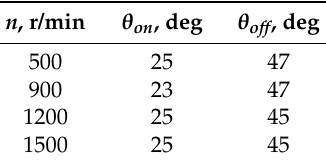
Figure 12. Optimize the θ off . ( a ) The trend of generation power; ( b ) the trend of ε . Table 1. The optimal θ on and θ off .